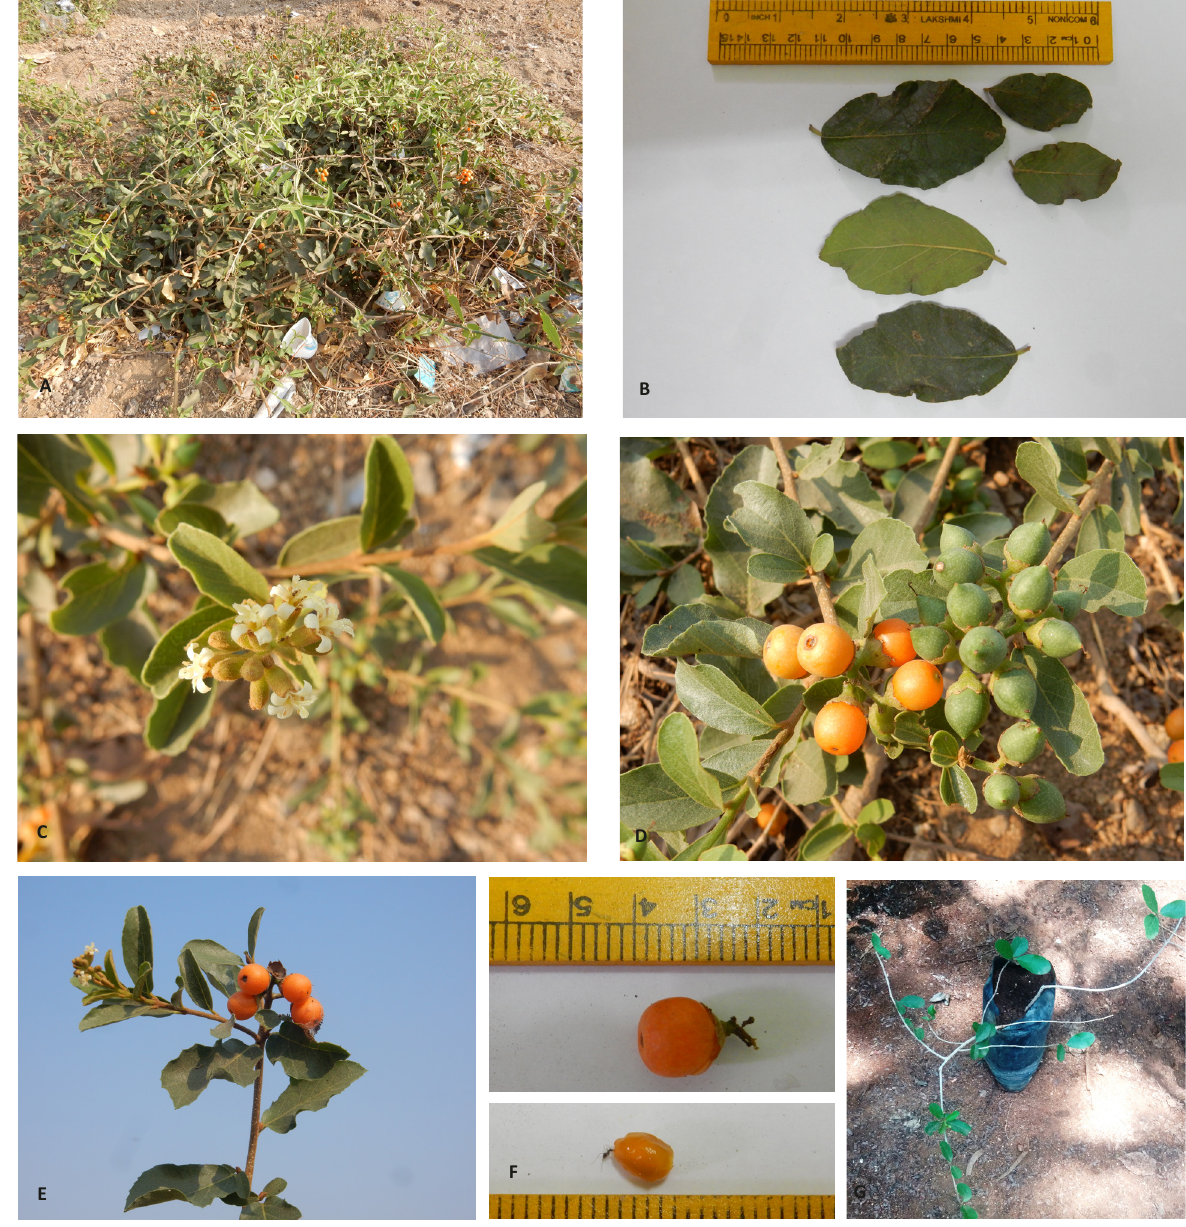
Image 1. Cordia diffusa K.C.Jacob: A—habit of the steno-endemic shrub | B—leaf morphology | C—close-up of inflorescence | D—a twig with immature and mature fruits | E—branch with flowers and fruits | F—close-up of a mature fruit and a seed (inset) | G—sapling from stem cutting. © A–F - K. Sampath Kumar | G - S.